Question: In a single sentence, describe what this figure presents.
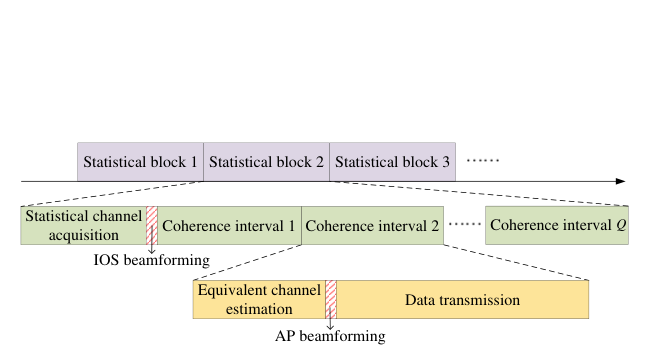
Answer: Illustration of the employed two-timescale channel estimation and beamforming protocol.